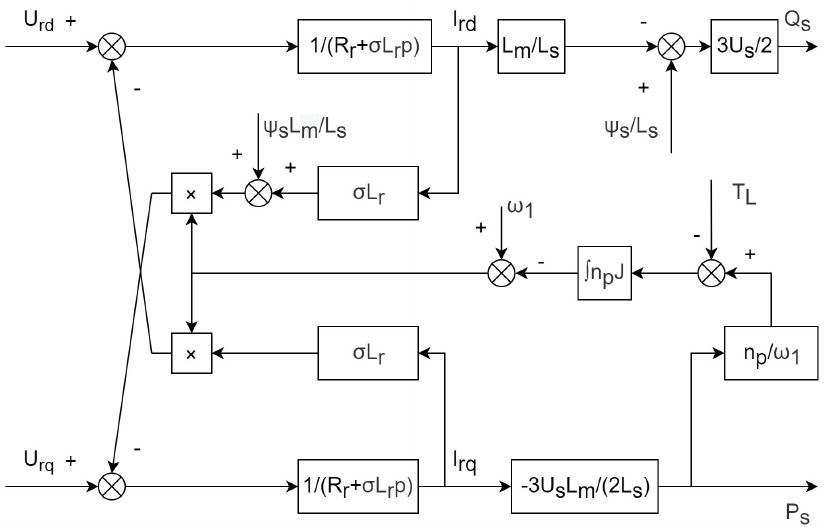
Figure 4. DFIG-model under stator flux orientation vector